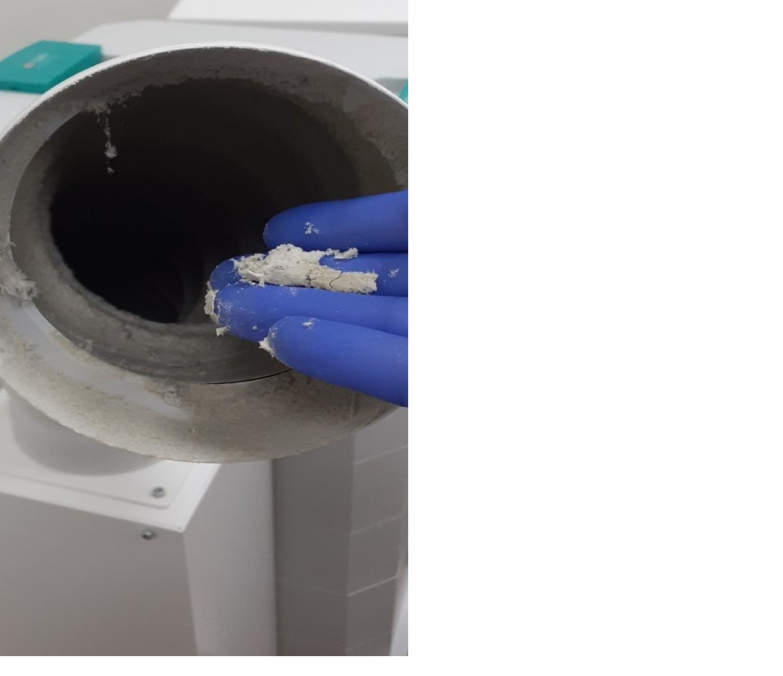
Figure 6. Close view of the previous picture (School of Dentistry, National and Kapodistrian Univer- sity of